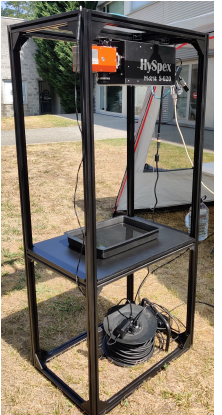
Figure 4. Test setup used during the laboratory test.